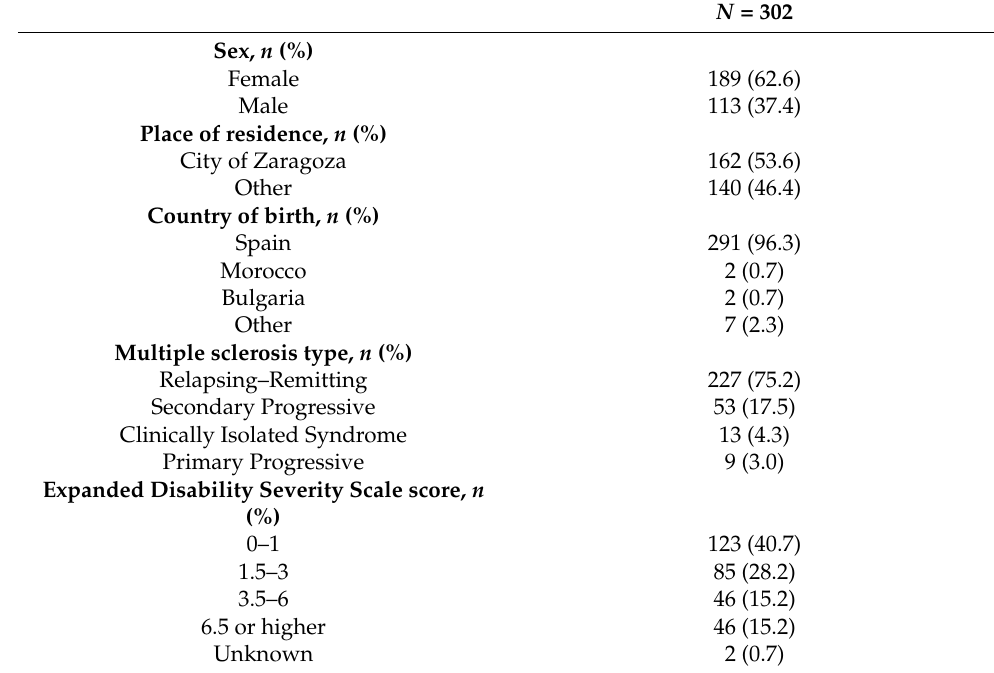
Table 2. Results of the descriptive